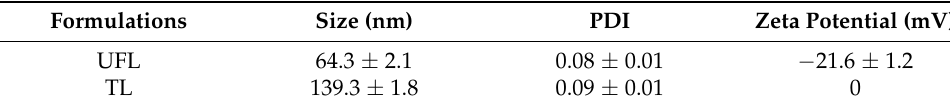
Table 1. The size, PDI, and zeta potential of UFLs and TLs.